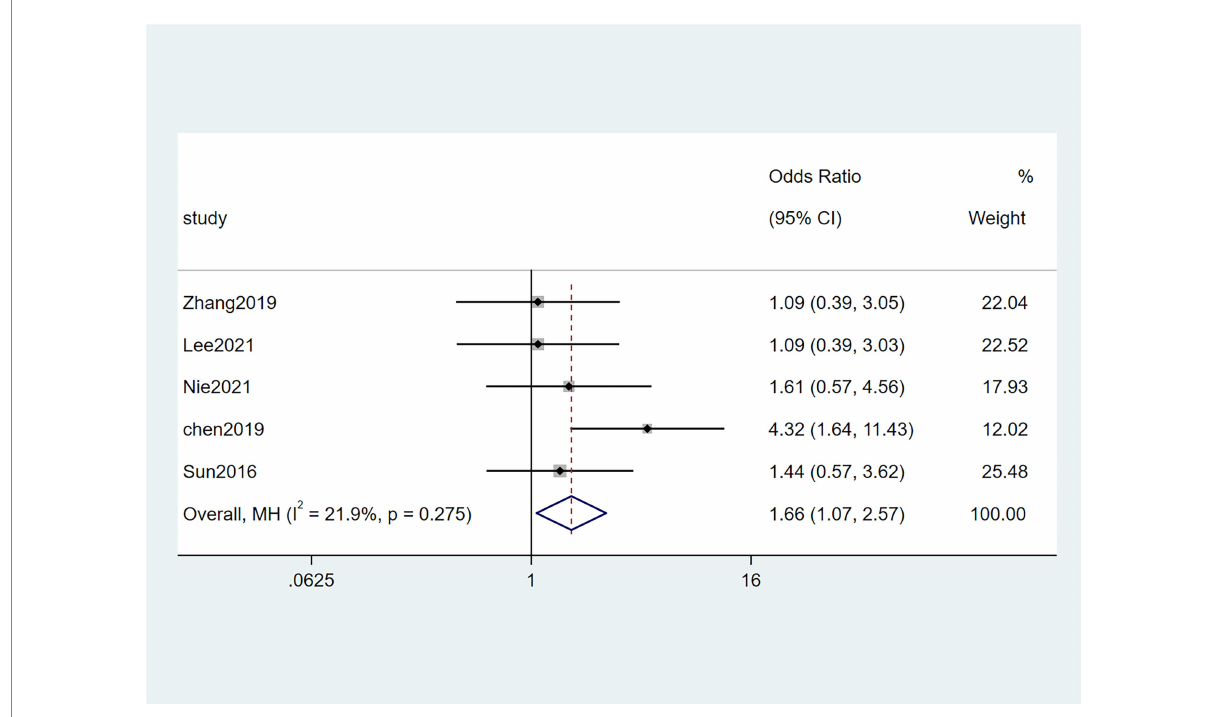
FIGURE 2 Forest plot of the relationship between Fusobacterium nucleatum and vascular invasion in